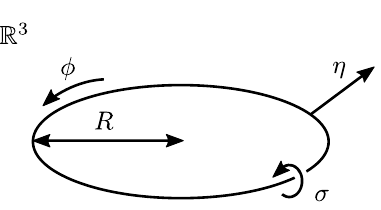
Figure 4 . Toroidal coordinates ( (cid:17); (cid:27); (cid:30) ). (cid:17) is a \radial" coordinate that decreases as one goes away from the ring, (cid:27) is the angular variable around the ring and (cid:30) is an angular variable along the ring.